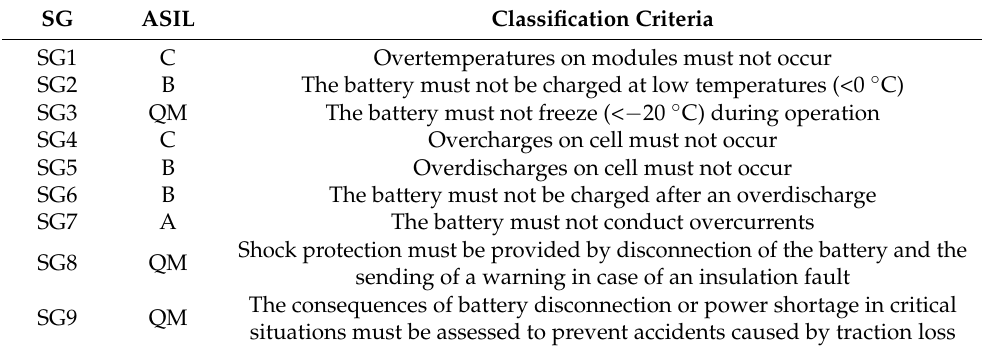
Table 4. Safety goals